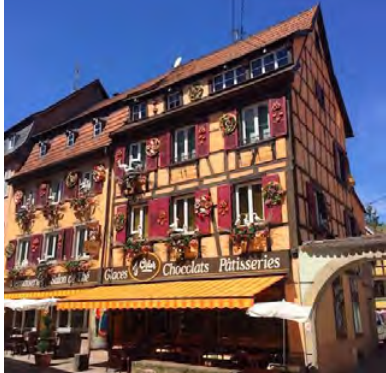
Figure 6. A semi-timbered house with flower decorations in Barr, northern Alsace (Courtesy of Alsace-wine-tour.com)